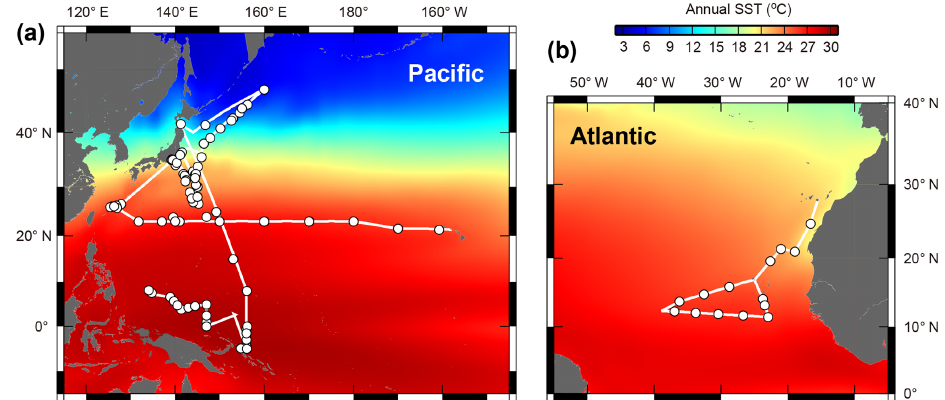
Figure 1. Maps showing the cruise tracks (lines) and the sampling points (circles). (a) Central and western Pacific area and (b) tropical eastern Atlantic area. See Table S1 for detailed sampling information. Annual sea surface temperature (SST) data were from the World Ocean Atlas 2013 (Locarnini et al.,